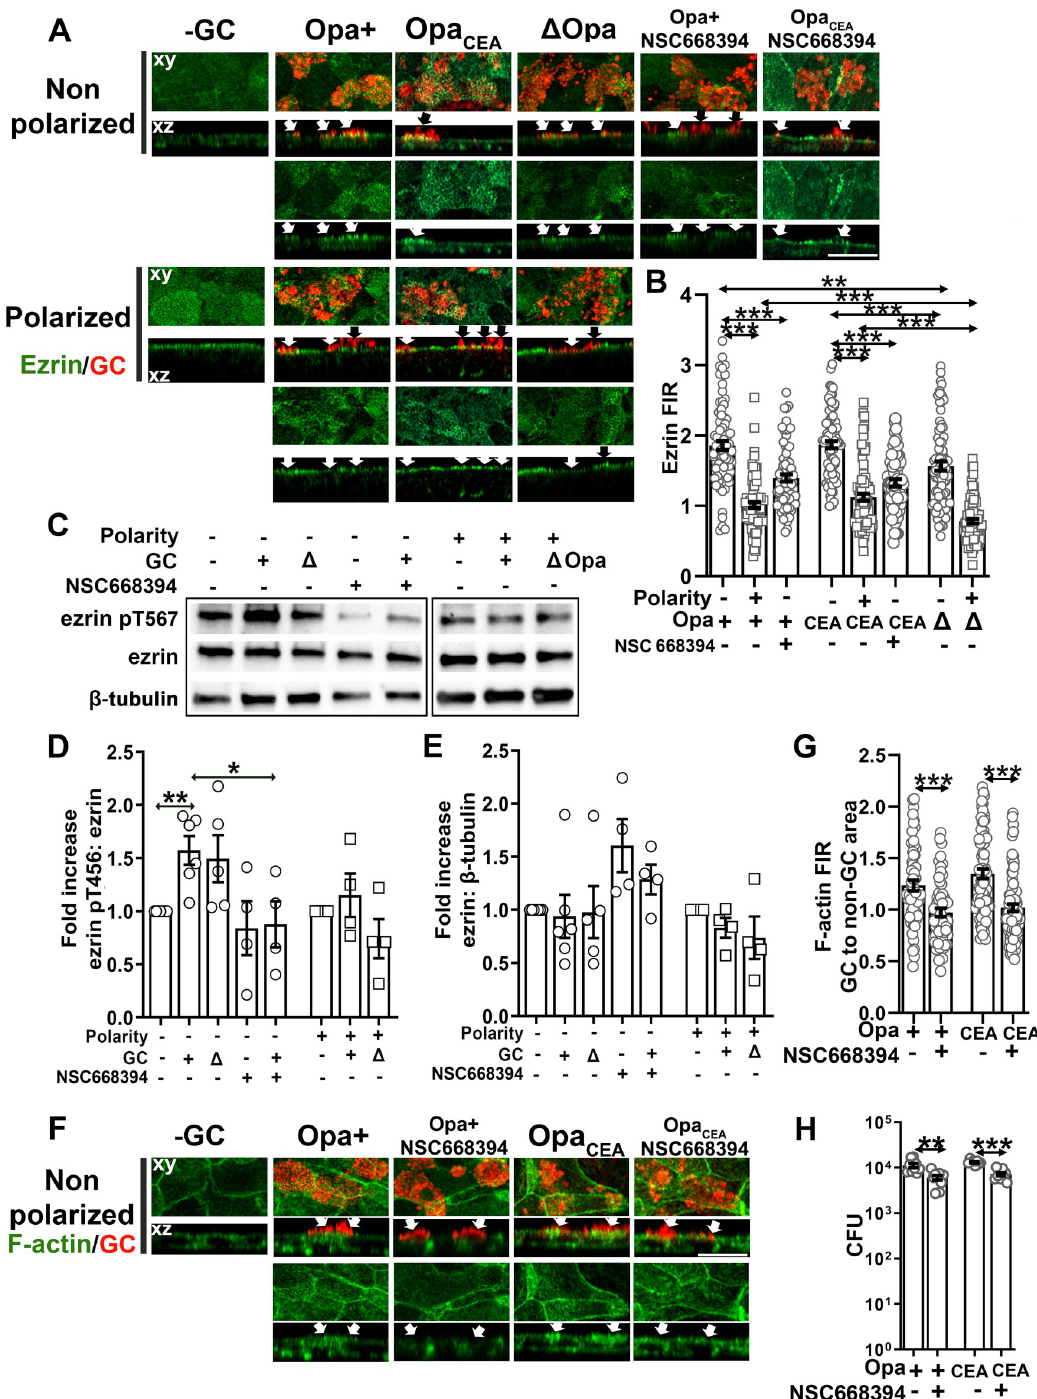
Fig 3. GC induce differential activation and redistribution of ezrin in non-polarized and polarized epithelial cells for actin reorganization and GC invasion. Non-polarized and polarized T84 were pretreated with or without the ezrin activation inhibitor NSC668394 (20 μ M) for 1 h and apically inoculated with Pil+Opa+, Opa CEA, or Δ Opa GC (MOI~10) for 6 h with or without the inhibitor. (A, B, F, G) Cells were fixed, permeabilized, stained for ezrin (A) , F-actin (F) , and GC, and analyzed using 3D-CFM. Shown are representative xy and xz images (A, F) . The levels of ezrin (B) and F-actin (G) redistribution were quantified by FIR ( ± SEM) underneath GC microcolonies relatively to the adjacent no GC surface area. Data points represent individual GC microcolonies. (C-E) Cells were lysed and analyzed by western blot. Shown are representative blots (C) . The average fold of